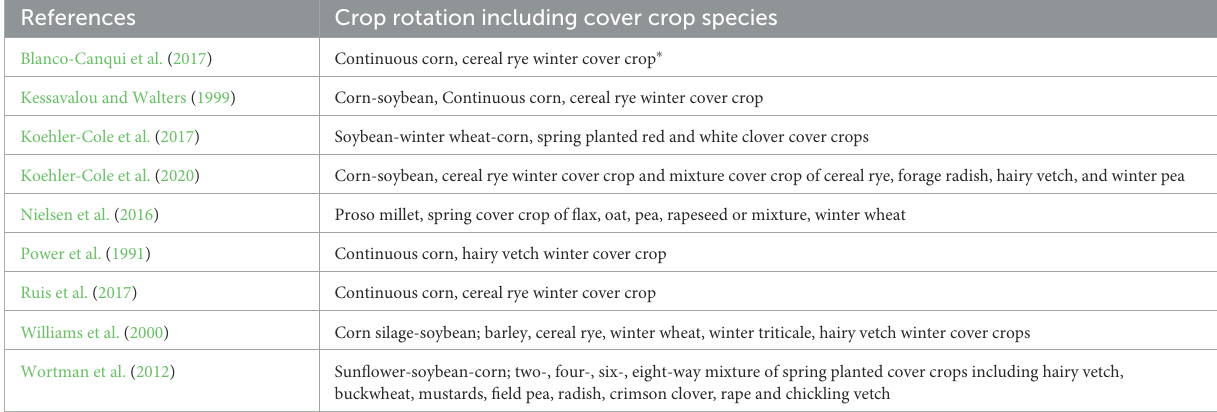
TABLE 1 List of researcher-led, peer-reviewed publications included in the